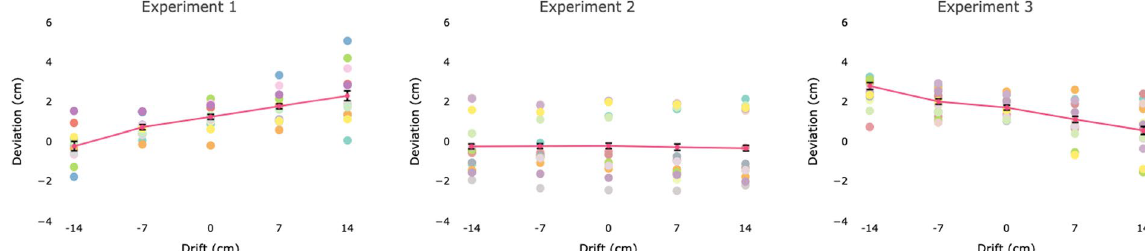
Figure 2. Deviation (computed as deviation in the y-axis of the endpoint of the moving hand from the target hand) across displacement magnitude in the three experiments. Positive values indicate upward deviation and negative values downward displacement towards the displaced hand in Experiments 1 and 2 and with respect to the non-displaced hand in Experiment 3. The error bars indicate standard errors of the mean. Individual participant’s performance for each displacement is represented with circular markers of different colors.